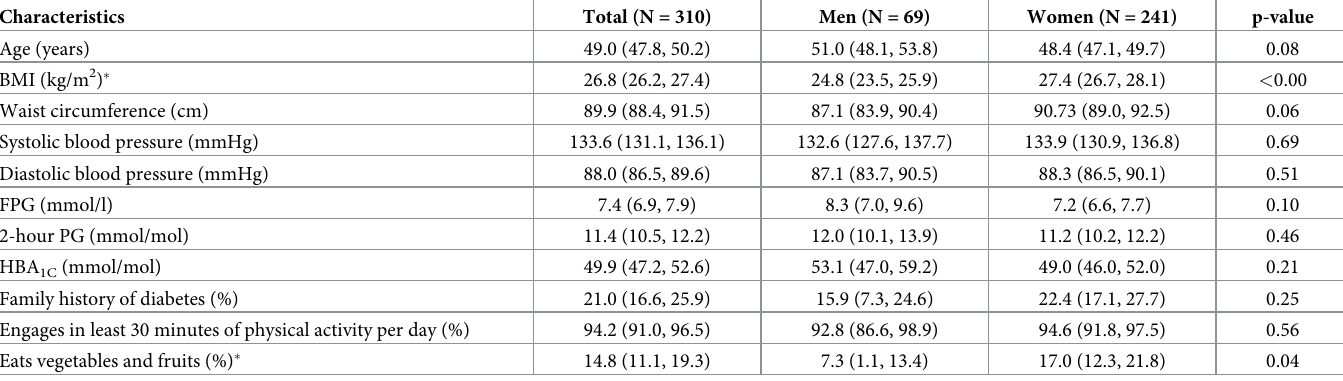
Table 1. Descriptive